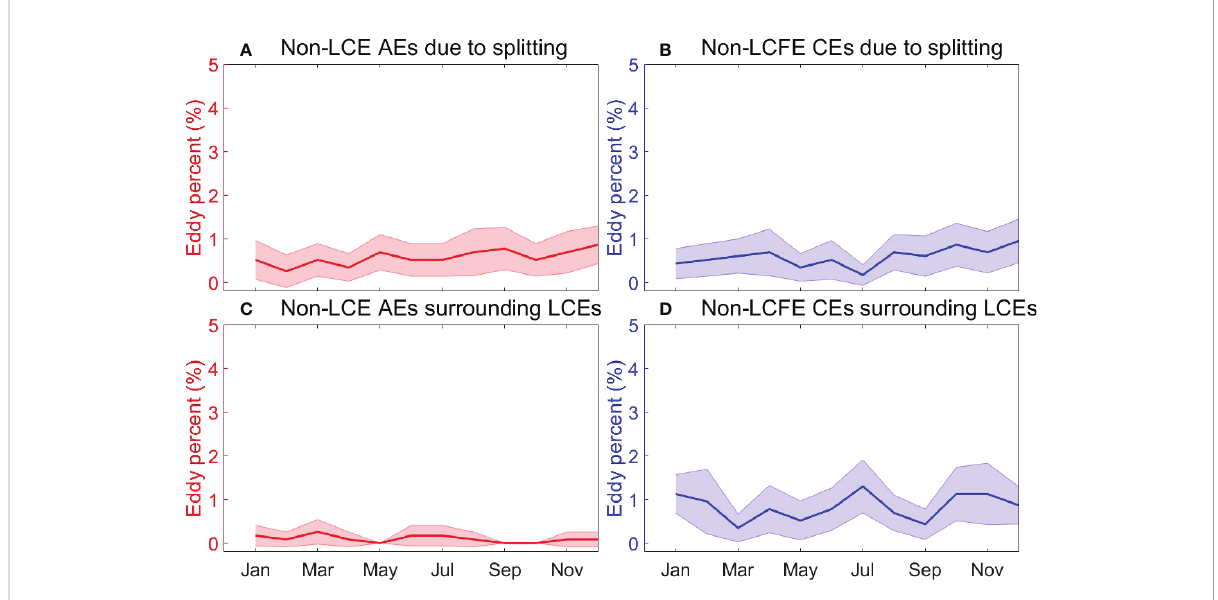
FIGURE 9 (A) The percentage of non-LCE AEs generated due to splitting relative to the total generated eddies. (B) The percentage of non-LCFE CEs generated due to splitting relative to the total generated eddies. (C) The percentage of non-LCE AEs generated within LCE radius plus 100 km relative to the total generated eddies. (D) The percentage of non-LCFE CEs generated within LCE radius plus 100 km relative to the total generated eddies. The shading denotes the 95% con fi dence level represented by two times standard deviation of eddy percentage in each